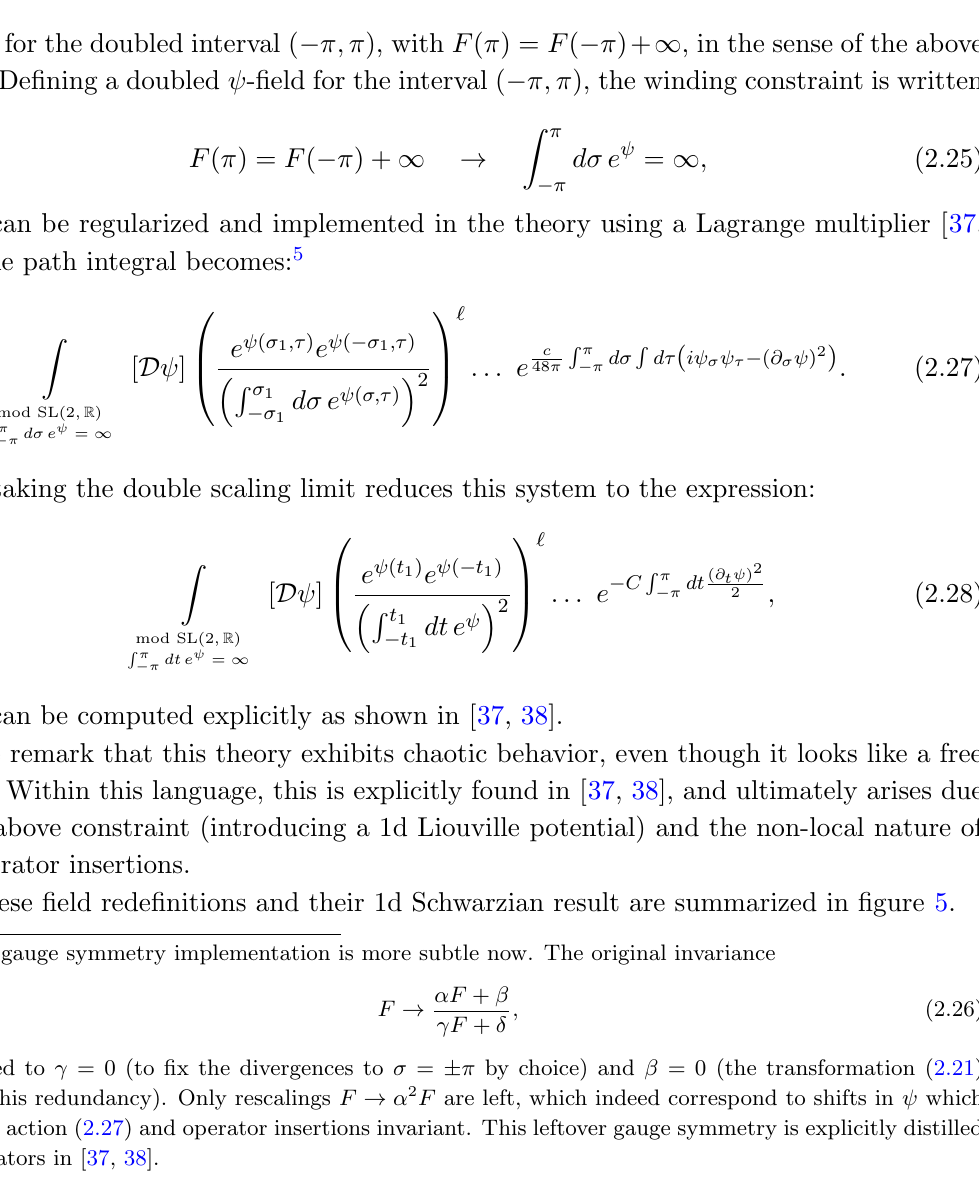
Figure 4 . Left: (cid:27) -dependence of A and B and their behavior at the branes at (cid:27) = 0 and (cid:27) = (cid:25) . Right: the doubling trick allows a description in terms of a single function F ( (cid:27)